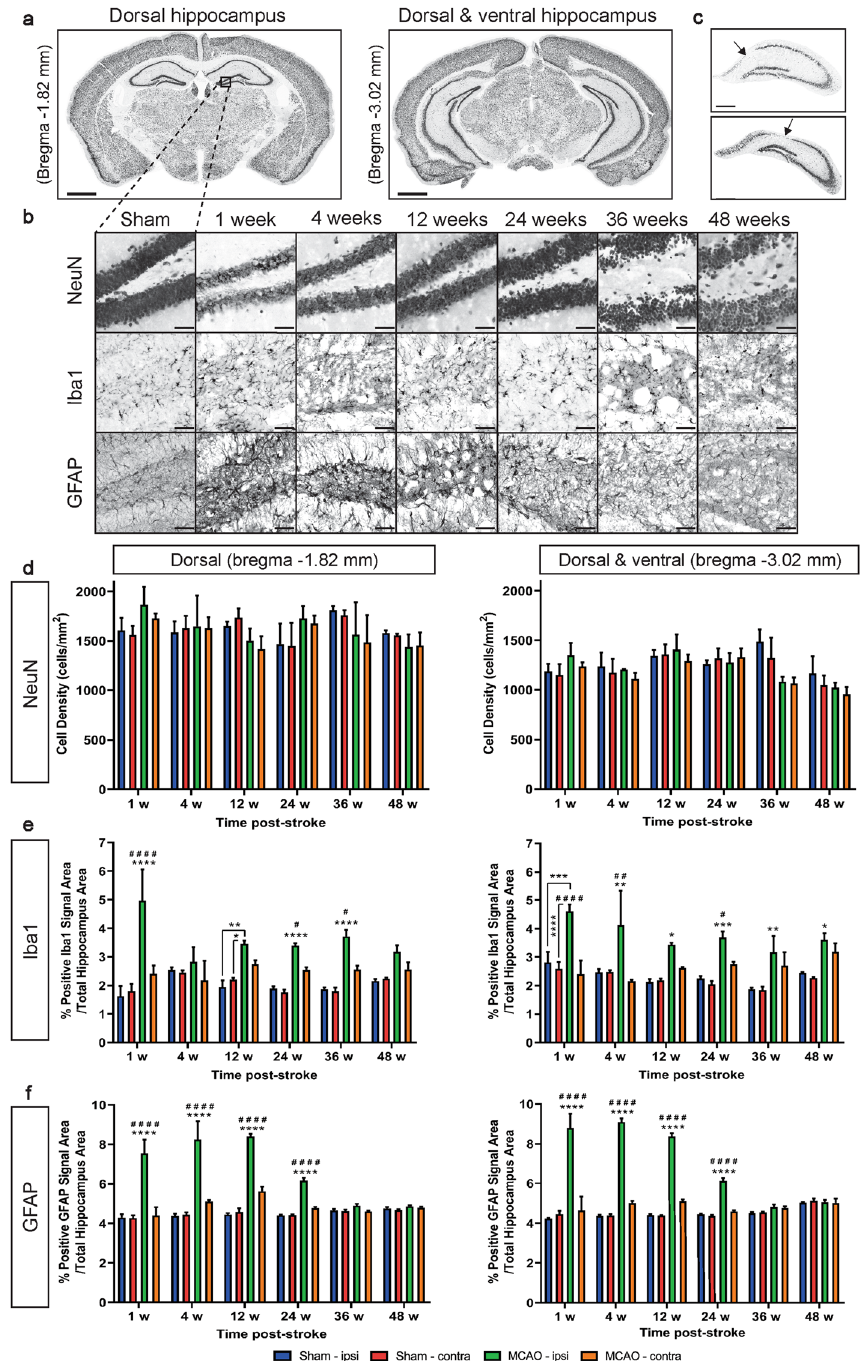
Figure 5. Histological Data. ( a ) A representative coronal image of sections -1.82 mm and -3.02 mm relative to bregma. Scale bar: 1 mm. ( b ) Representative NeuN (neurons), Iba1 (microglia), and GFAP (astrocytes) staining in the hippocampus of a sham-operated mouse, and an MCAO-operated mouse at each time point at bregma -1.82 mm. Scale bar: 50 µm. ( c ) Representative images of CA1 neurodegeneration in the ipsilateral hippocampus of an MCAO-operated mouse at 12-weeks (top image) and 24-weeks post-stroke (bottom image). Arrow indicates neurodegeneration. Scale bar: 250 µm. Neuronal ( d ), microglial ( e ) and astrocytic ( f ) density in the ipsilateral and contralateral hippocampus at bregma −1.82 mm and −3.02 mm in sham-operated mice (blue and red, respectively) and MCAO-operated mice (green and orange, respectively) at each time point measured (n = 2–6). Data are presented as mean ± s.e.m. * p < 0.05; ** p < 0.01; *** p < 0.001; **** p < 0.0001 compared to both ipsilateral and contralateral sham unless otherwise specified, # p < 0.05; ## p < 0.01; #### p < 0.0001 compared to contralateral MCAO, two-way ANOVA followed by a Sidak post-hoc